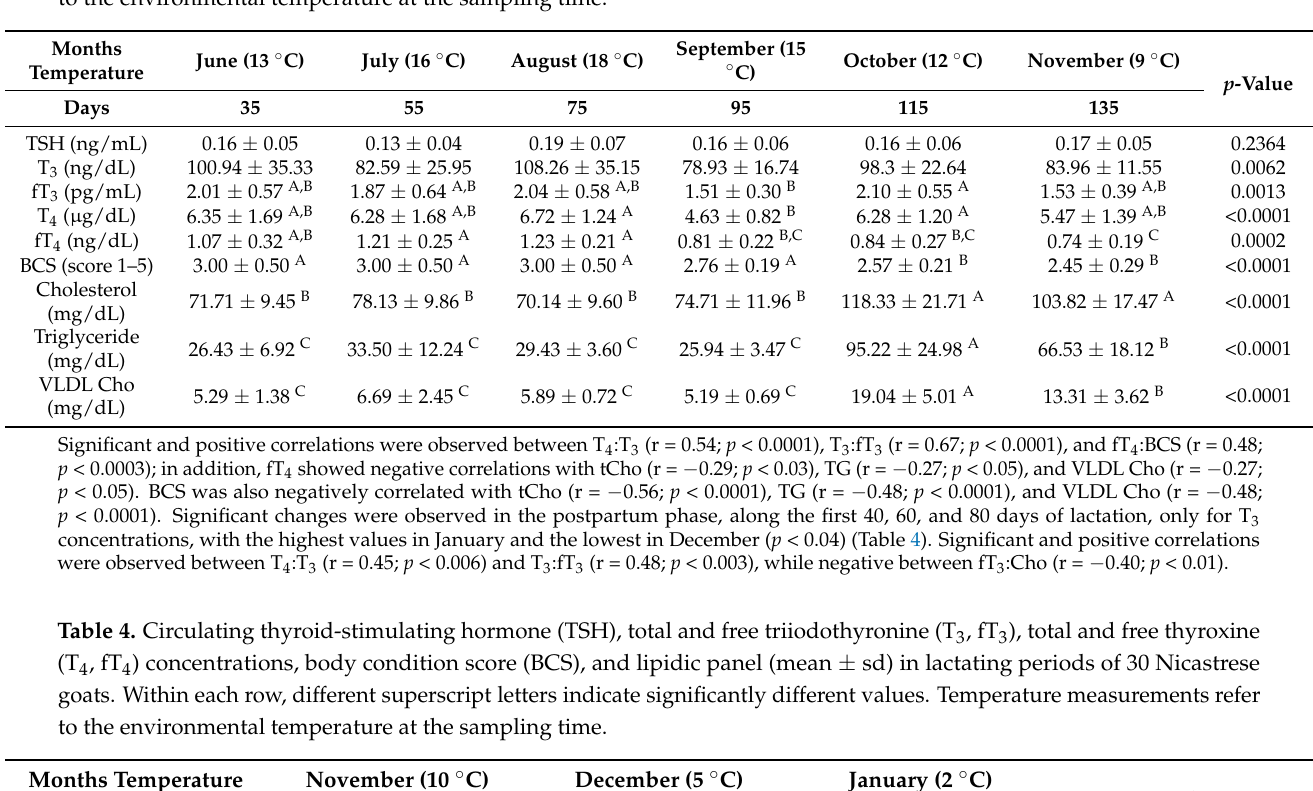
Table 3. Circulating thyroid-stimulating hormone (TSH), total and free triiodothyronine (T 3 , fT 3 ), total and free thyroxine (T 4 , fT 4 ) concentrations, body condition score (BCS), and lipidic panels (mean ± sd) in pregnant periods of 30 Nicastrese goats. Within each row, different superscript letters indicate significantly different values. Temperature measurements refer to the environmental temperature at the sampling time.